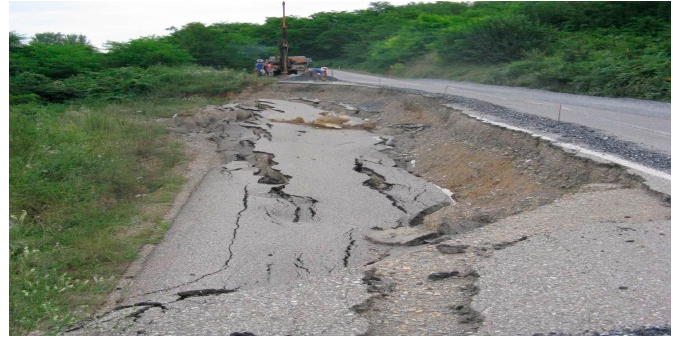
Figure 3. Slope on the section: Šabac-Tekeriš-Zavlaka at km 10 + 225 [24].